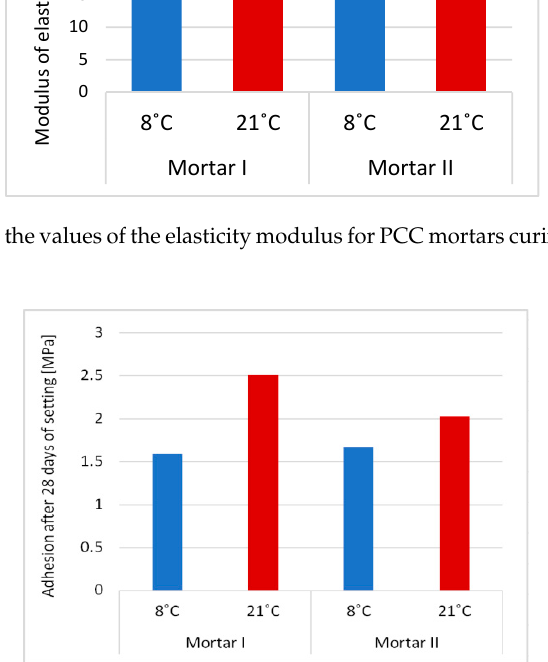
Figure 7. Differences in the values of the elasticity modulus for PCC mortars curing at two temperatures: 8 °C and 21 °C.